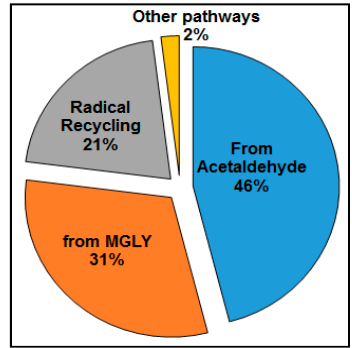
Figure 8. Contributions of different pathways to PA production at the BGS site.